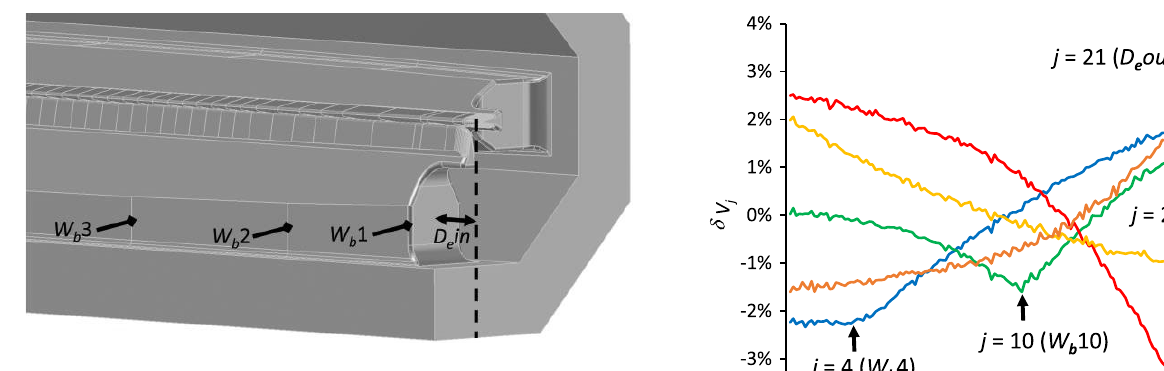
FIG. 3. Vane model for tuning the W b ’ s and the D e ’ s. Actual eigenmode calculation was done in one quadrant assuming fourfold symmetry.